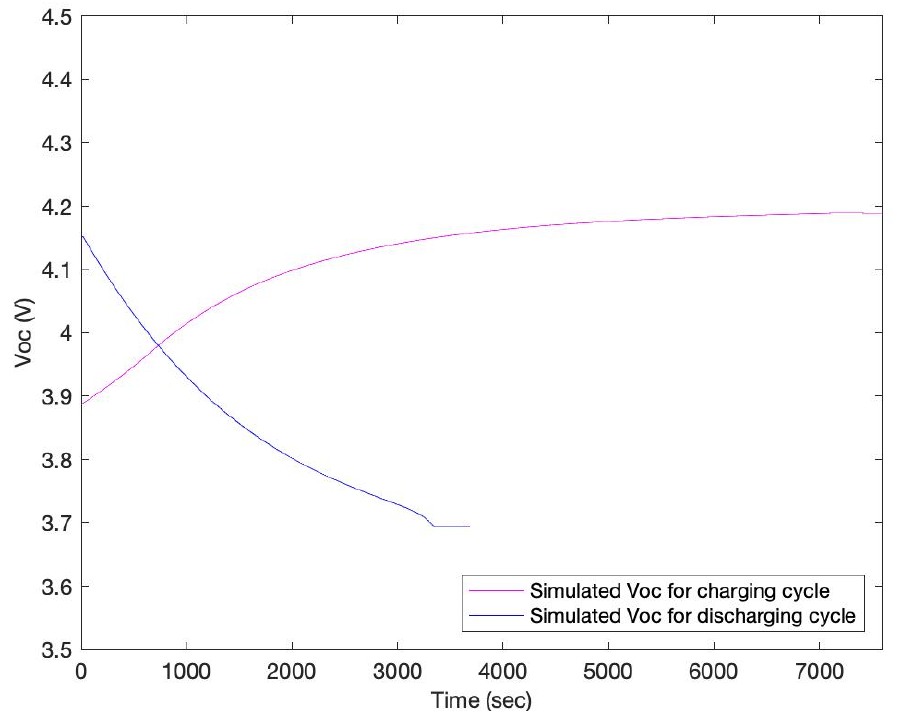
Figure 5. The change in the simulated battery open-circuit voltage over time for the charging/discharging profiles.